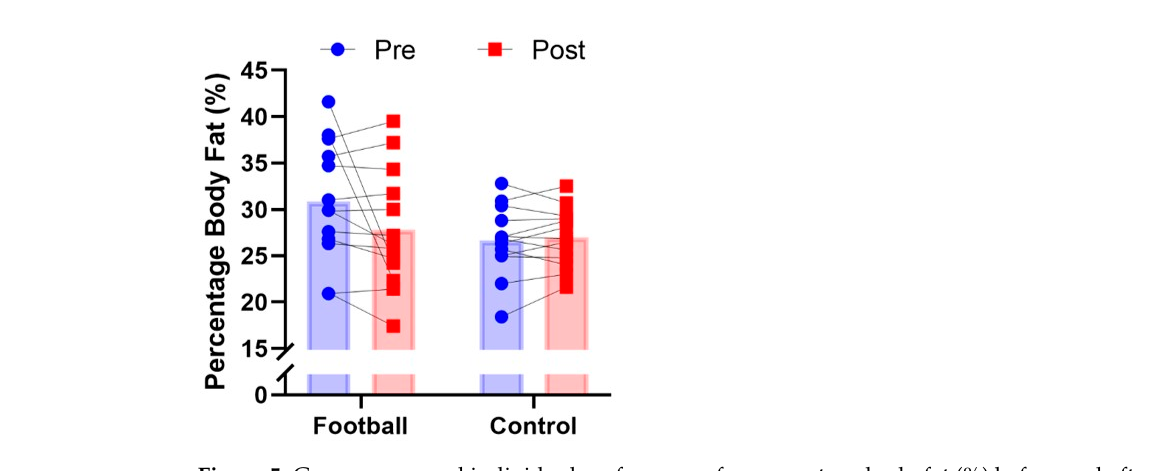
Figure 4. Group mean and individual performance for 6 min walk test performance (m) before and after in recreational football for health intervention group and matched controls (* p < 0.05).